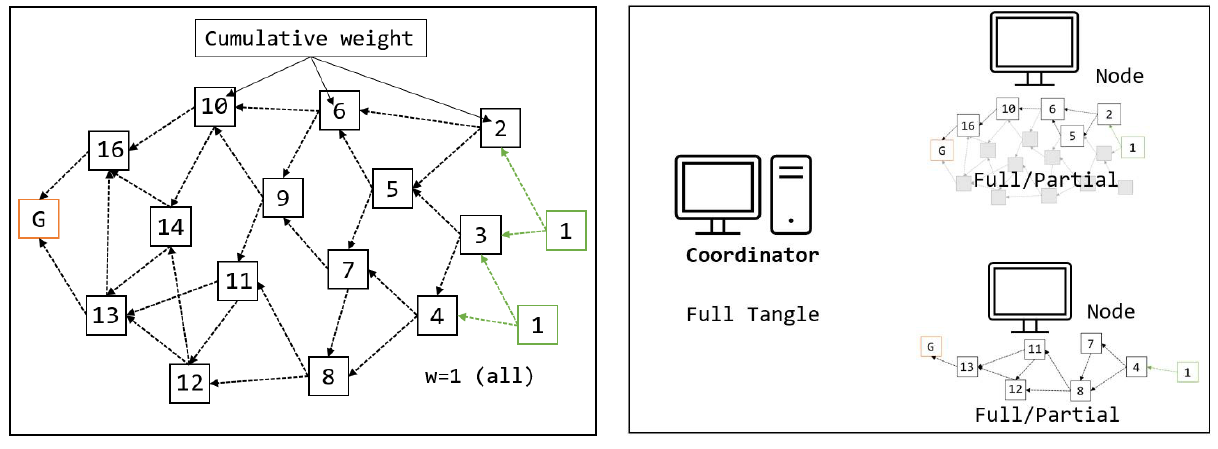
Figure 2. Tangle structure and network.